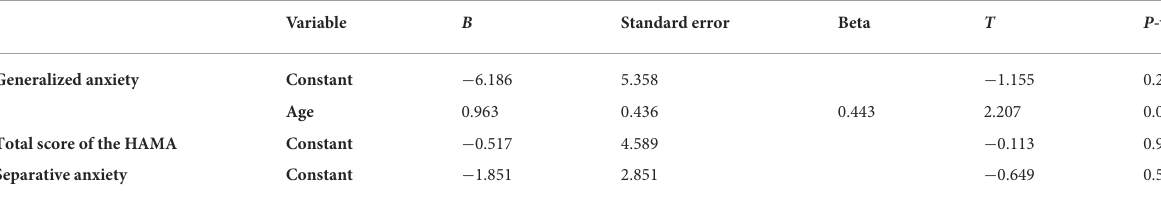
TABLE 3 Regression analysis of factors related to anxiety and depression in DSDs